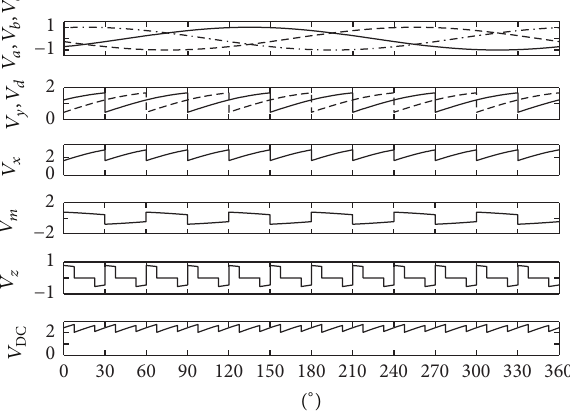
Figure 3: Theoretical DC voltage waveforms for 3-level thyristor based MLCR CSC for 𝛼 = − 45 ∘